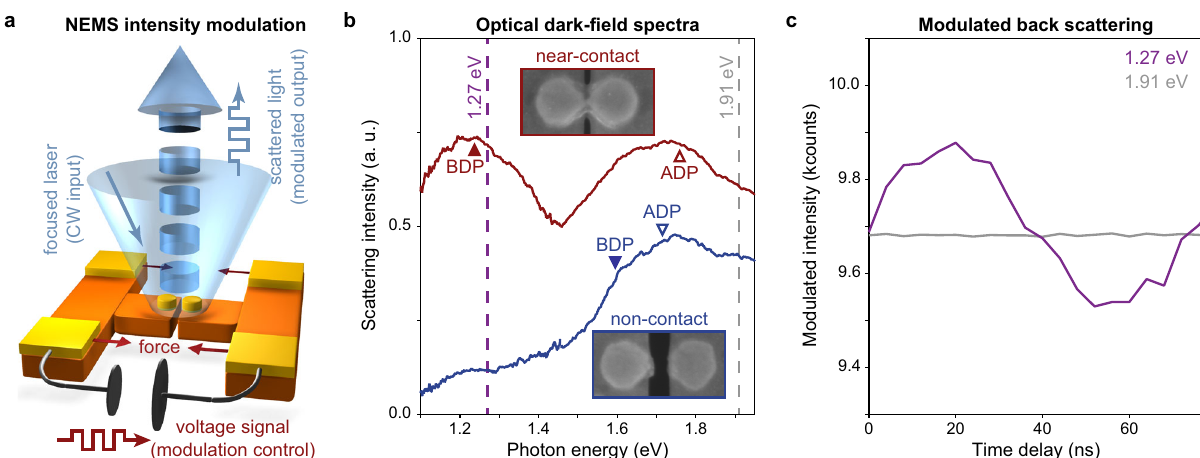
Fig. 4 Dynamic light intensity modulation in a nanoelectromechanical device. a Schematic of the light intensity modulation experiment. b Resonant dark- fi eld scattering spectra taken from the dimer when there is only a 1.5-nm-thick EBID spacer layer separating the two Au nanoparticles (red curve) and for the case of a 30 nm spacing (blue curve). For clear comparison, two different offsets of 0.15 and − 0.35 are applied to the red and blue spectra, respectively. The magenta and gray dashed lines indicate the photon energies of the CW excitation on resonance (1.27 eV) and off resonance (1.91 eV), respectively. The triangular symbols indicate the resonance frequencies of each mode at 1.5 nm (red) and 30 nm (blue) gap sizes. c Time-modulated intensity signal from dimer with the 1.5-nm-EBID spacer as measured by time-correlated single-photon counting. Line plots indicate the averaged intensity in each 4-ns-wide time bin (1000 data points within each 4 ns bin). To allow easy comparison, an offset of 8 kcounts is applied to the modulated intensity for 1.91 eV laser